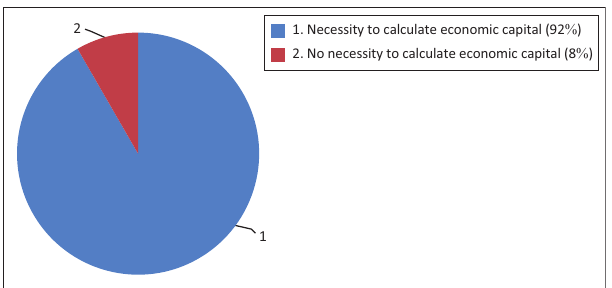
FIG URE 8: Necessity to calculate economic capital.